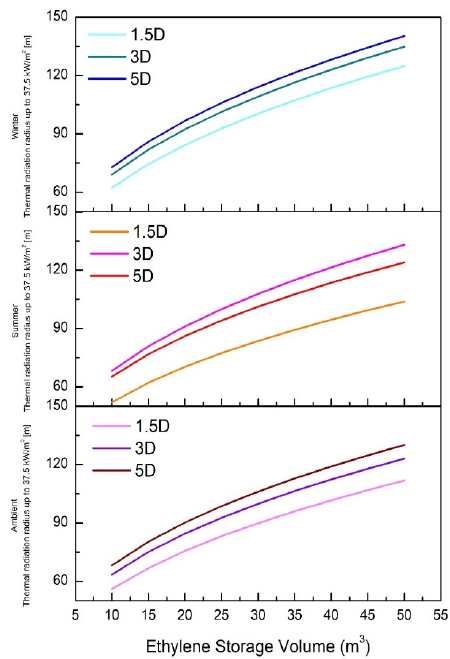
Figure 4. Thermal radiation radius up to 37.5 kW/m 2 according to ethylene storage capacity in ambient temperature (25 °C), summer (40 °C), and winter (0 °C) conditions.